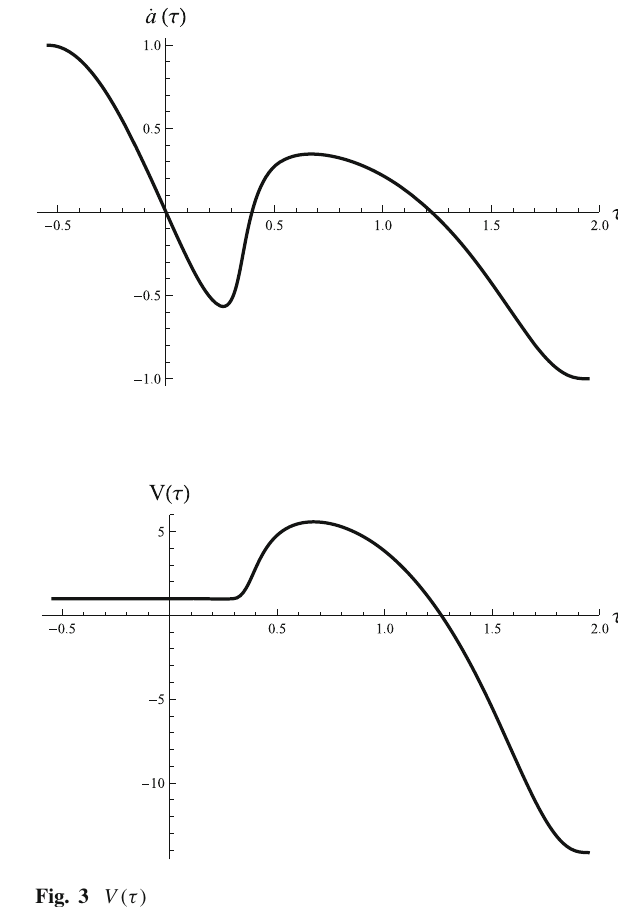
Fig. 3 V (τ) ends of a = 0 correspond null surfaces. Beyond the